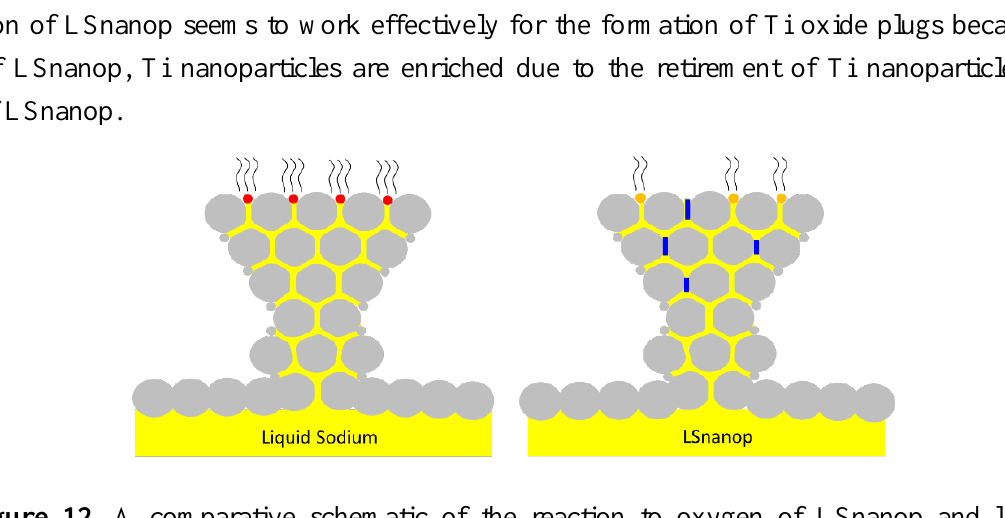
Figure 12. A comparative schematic of the reaction to oxygen of LSnanop and liquid sodium; blue bars: titanium oxide plugs; small dots of red and bitter orange: burning